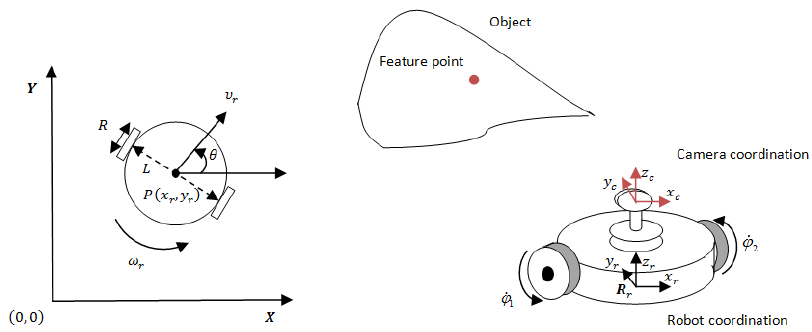
Figure 1. Three-dimensional visual servoing — block diagram.